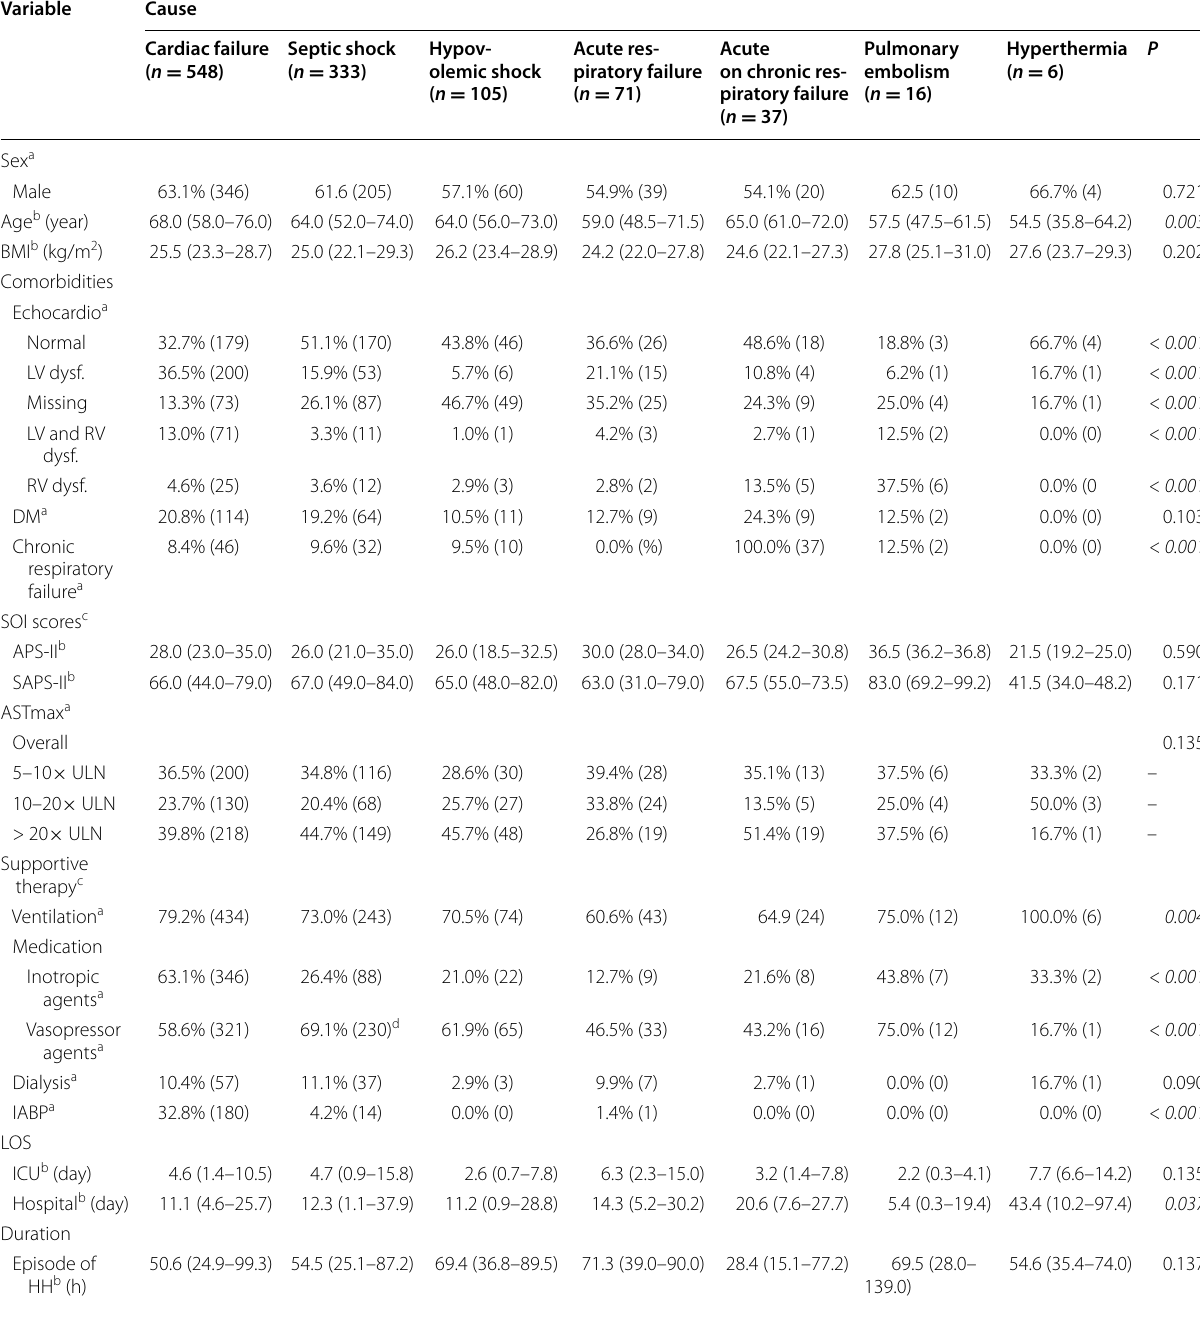
Table 3 Characteristics of patients with HH classified by clinical cause